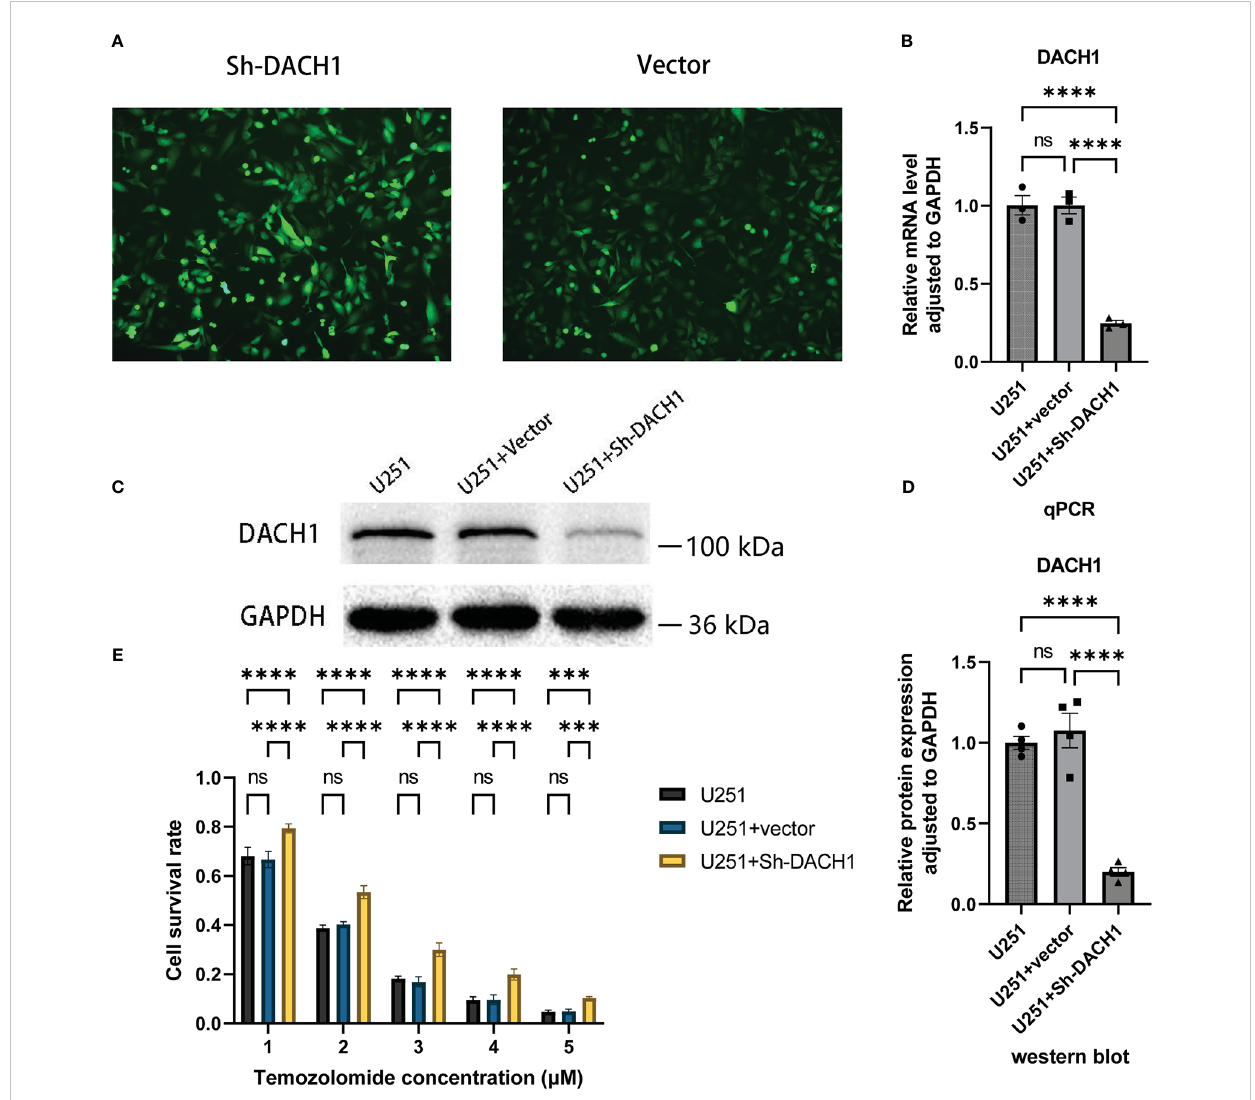
FIGURE 8 (A) The U251 cells in the Sh-DACH1 group and the Vector group display green fl uorescence after successful transfection. (B) The results of PCR experiments showed that the relative RNA expression of DACH1 (adjusted to GAPDH) was signi fi cantly lower in the U251+Sh-DACH1 group than in the U251 group and the U251+Vector group (P < 0.05). (C) The results of western blot experiments indicated that the gray degree of DACH1 was signi fi cantly lower in the U251+Sh-DACH1 group than in the U251 group and the U251+Vector group. (D) The statistical results of the gray values show that the relative protein expression of DACH1 (adjusted to GAPDH) was signi fi cantly lower in the U251+Sh-DACH1 group than in the U251 group and the U251+Vector group. (E) The result of temozolomide toxicity experiments showed that the survival rate of the Sh-DACH1 group was signi fi cantly higher than that of the U251 group and the U251-vector group at different concentrations of temozolomide (P <